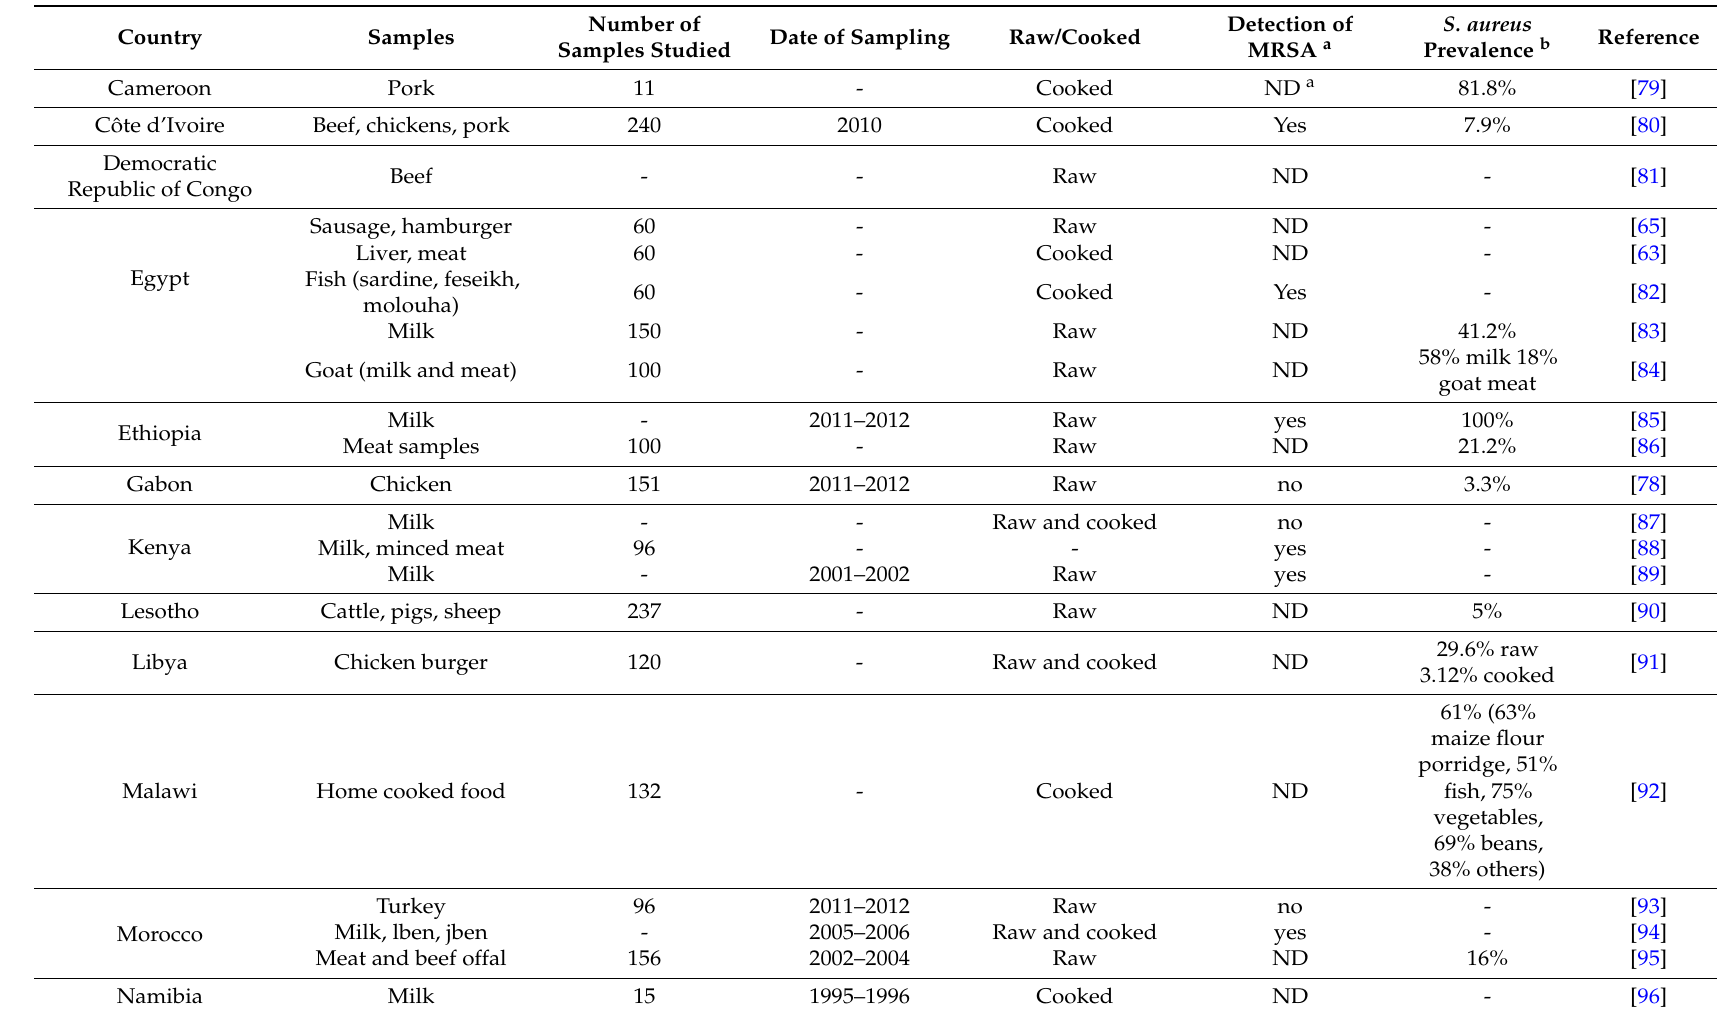
Table 2. Detection of S. aureus in food from healthy animals in the African